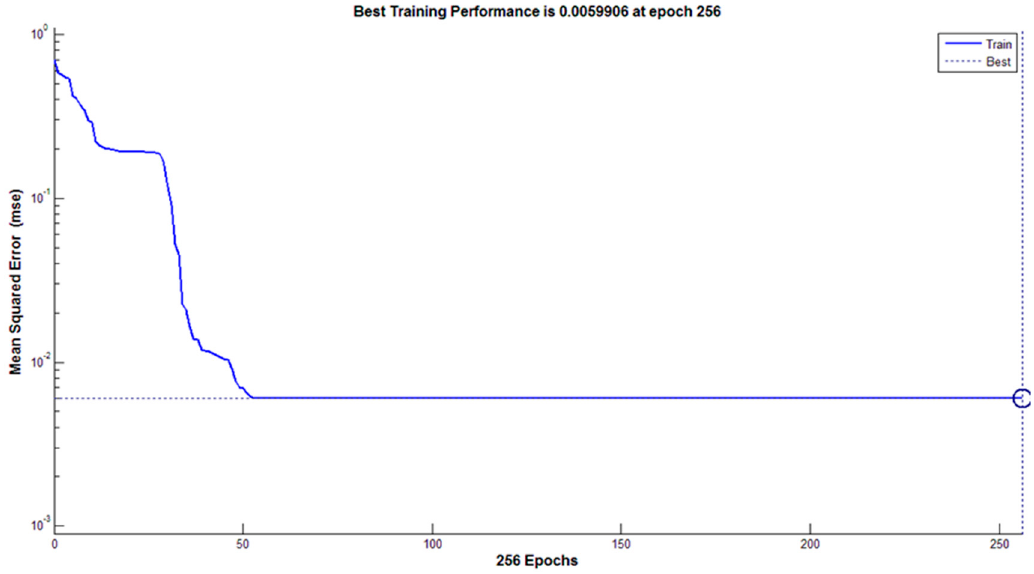
Figure 20. The curve of how to train a designed neural network to identify and classify white rice cultivars.